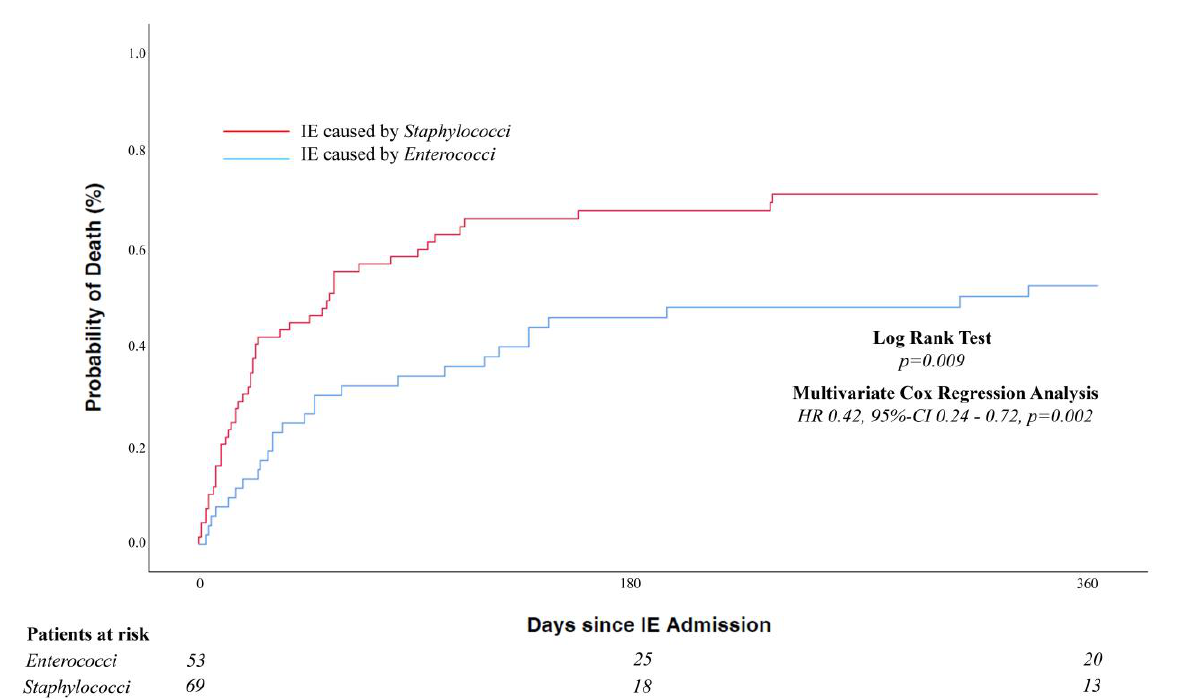
Figure 1. All-cause mortality according to IE caused by enterococci vs. staphylococci . HR indicates hazard ratio (adjusted by age, sex, BMI, atrial fibrillation, and new pacemaker implantation); CI, confidence interval; IE, infective endocarditis.